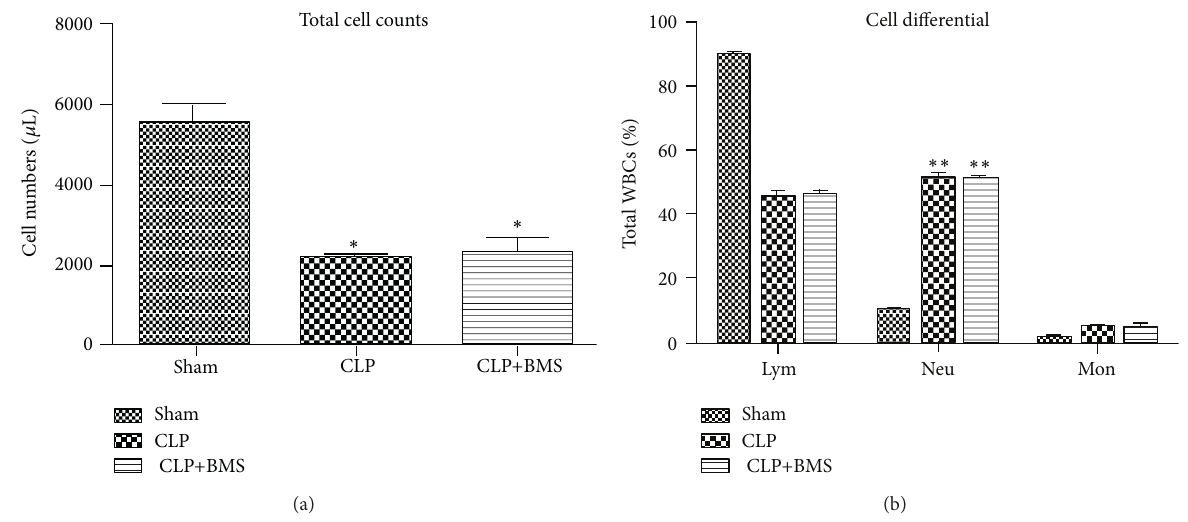
Figure 2: BMS-345541 treatment did not affect peripheral WBC counts in mice subjected to CLP. (a) Peripheral WBCs were counted in control mice treated with sham laparotomy (sham), mice that underwent CLP followed by vehicle (CLP), and mice treated with CLP followed by BMS-345541 (CLP+BMS) at 24 hours after surgery. 𝑁 = 5 per group; ANOVA test was used for comparison among multiple groups. Tukey post hoc tests were undertaken after ANOVA. There were significant differences for sham versus CLP or CLP+BMS ( ∗ 𝑃 < 0.05 for CLP and CLP+BMS versus sham), while there was no significant difference between CLP and CLP+BMS mice. (b) Differential WBC counts in mice with sham surgery, mice treated with CLP (+vehicle), and mice treated with CLP+BMS at 24 hours after CLP. 𝑁 = 5 per group; ANOVA test ( 𝑃 < 0.0001 ) was used for comparison among multiple groups. Tukey post hoc tests were undertaken after ANOVA. There were significant differences for sham versus CLP or CLP+BMS mice ( ∗∗ 𝑃 < 0.0001 for CLP and CLP+BMS versus sham), while there was no significant difference between CLP and CLP+BMS mice. Results are presented as mean ±